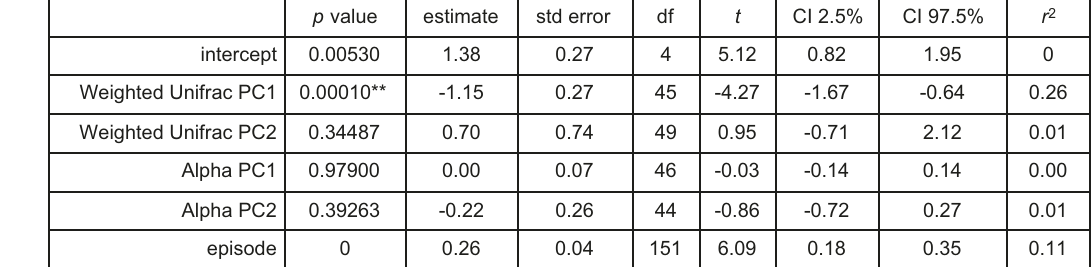
Fig. 5 Associations between 1-year microbiome and non-social fear behavior. a – e Scatterplots displaying relationships between Weighted Unifrac principal coordinate 1 at 1 year of age and average scores of bodily fear, escape behavior, facial fear, vocal distress, and startle response during the Mask Task paradigm at 1 year of age, respectively. Each dot represents a single subject. f Two-level linear mixed effects model with t test, **denotes signi fi cance after Bonferroni correction for multiple comparisons, threshold for signi fi cance of p = 0.00208, *denotes p < 0.05, n = 14 independent participants. Source data for this fi gure are provided as a Source Data fi